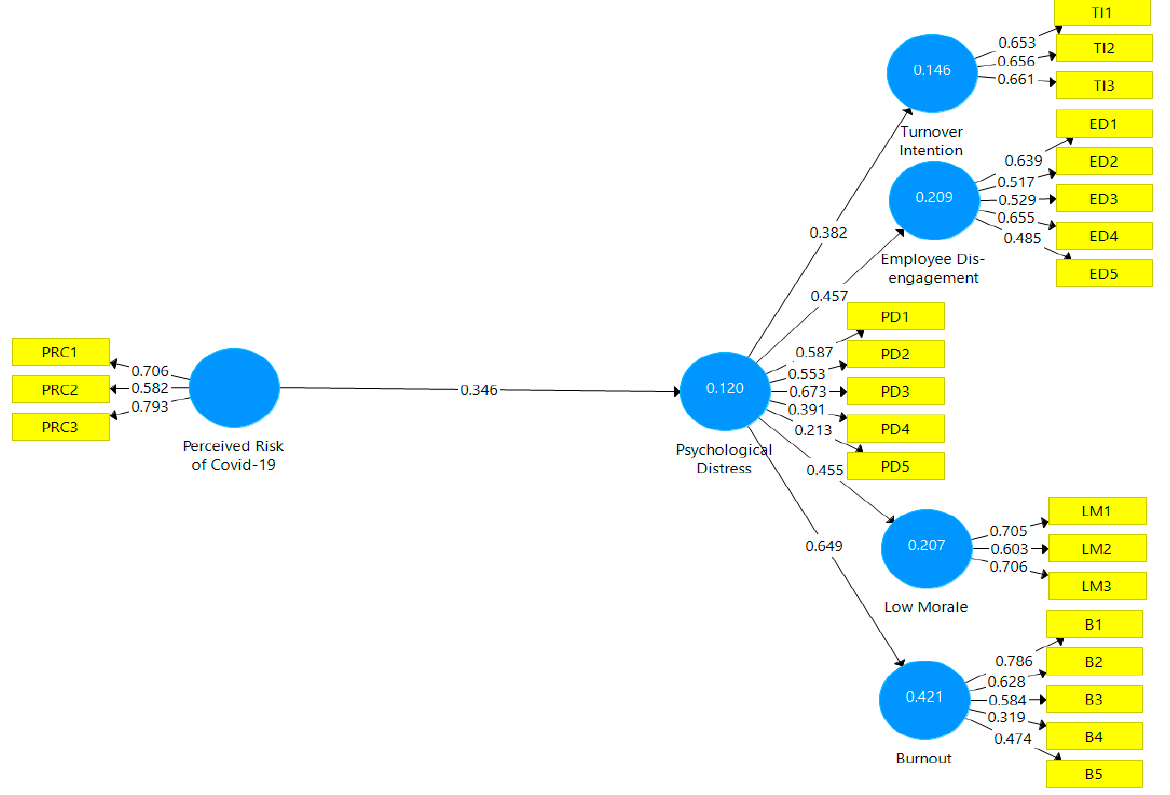
Figure 2. Assessment of measurement model .